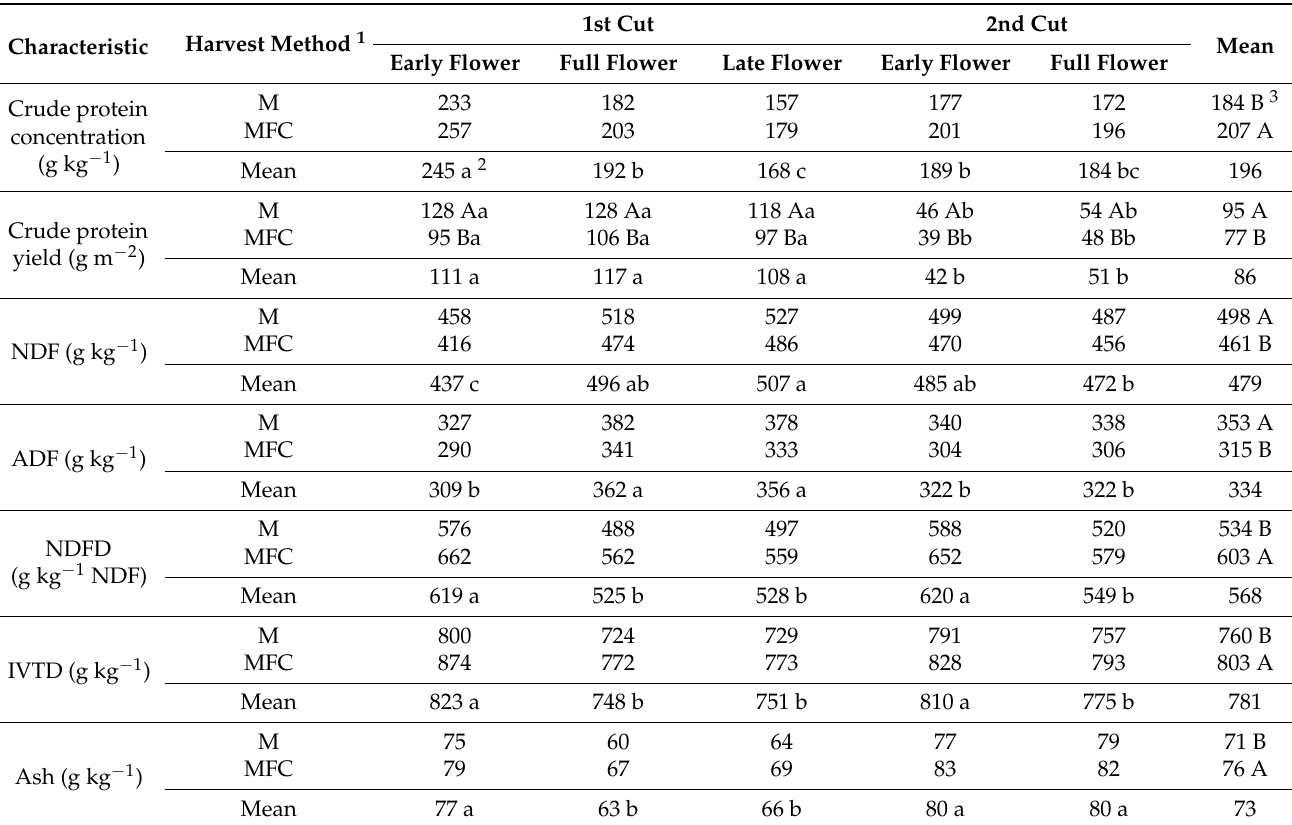
Table 4. Concentration and yield of CP, concentration of NDF, ADF, NDFD, IVTD, and ash in galega at two cuts and three maturities, dependent on harvest method (mean for two years).